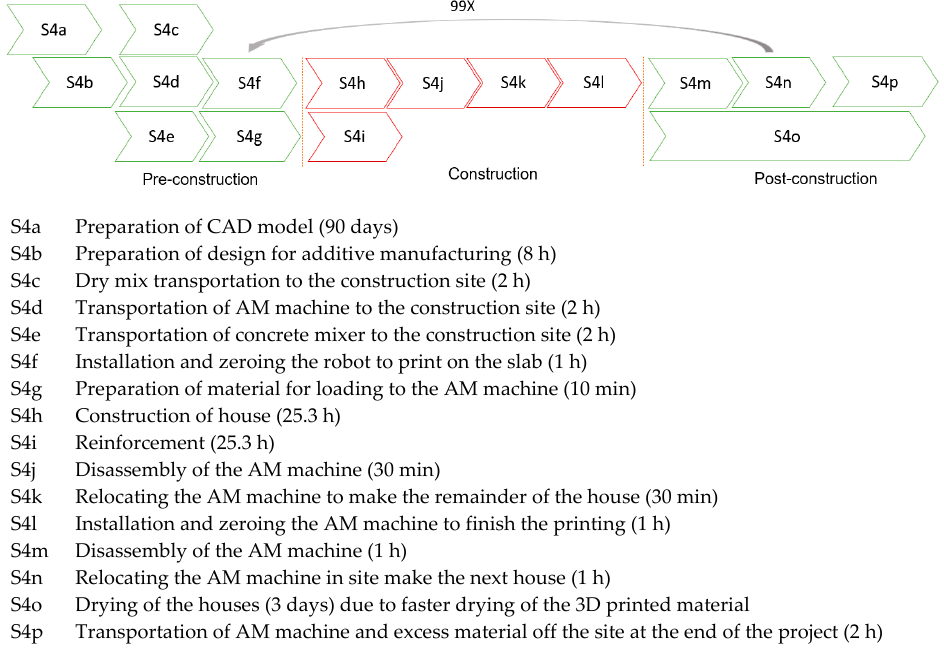
Figure 6. The process map for Scenario